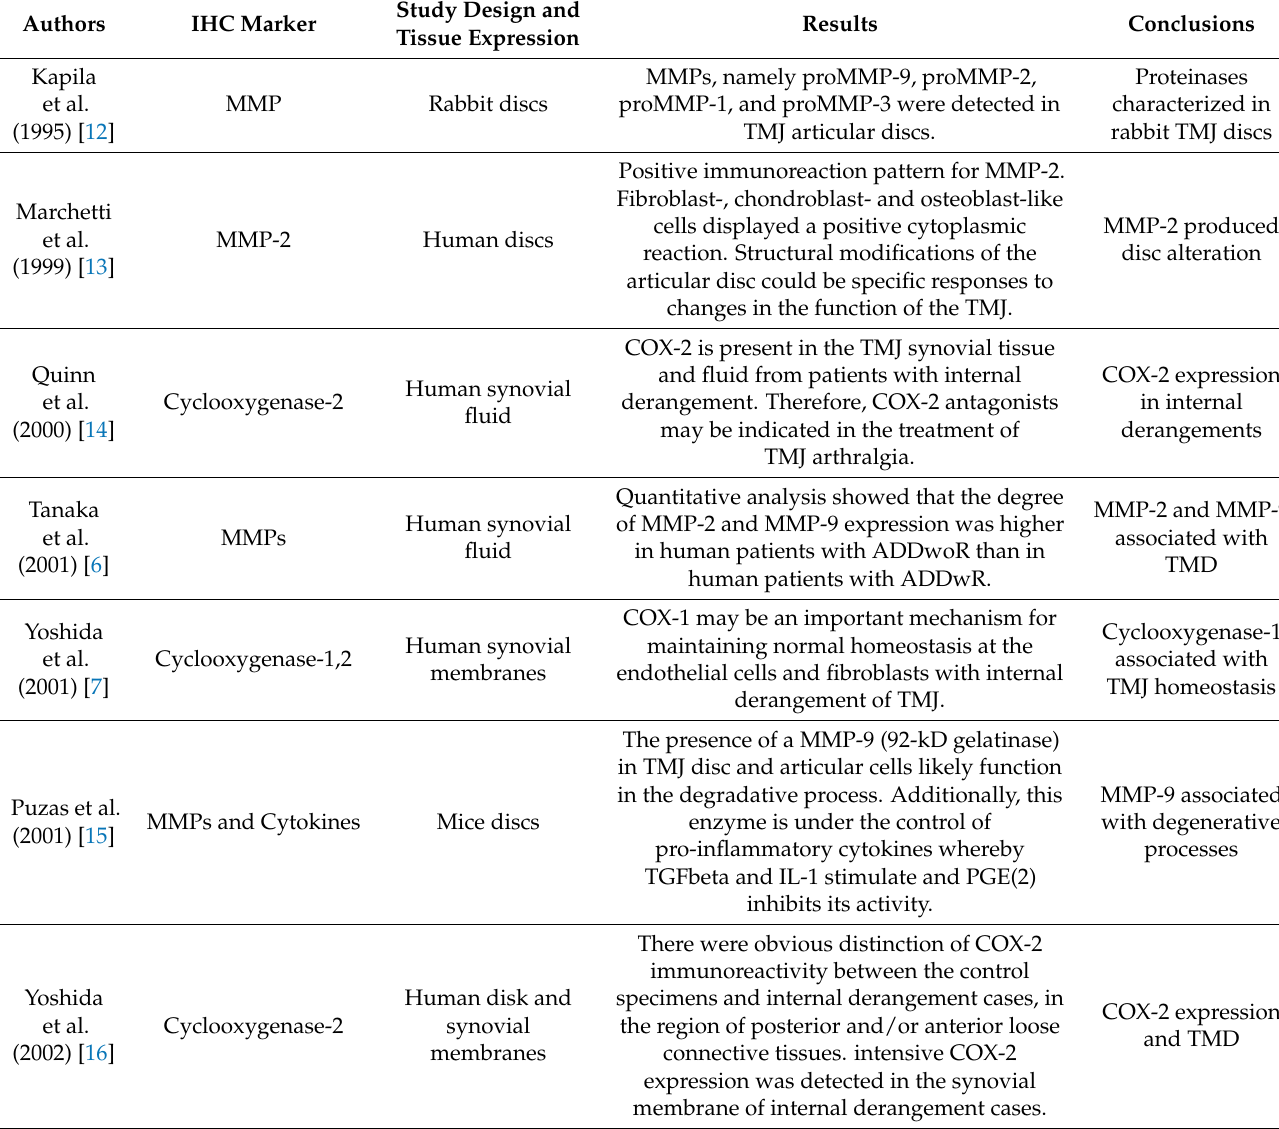
Table 1. Seven Enzymes (MMPs, aggrecanase,